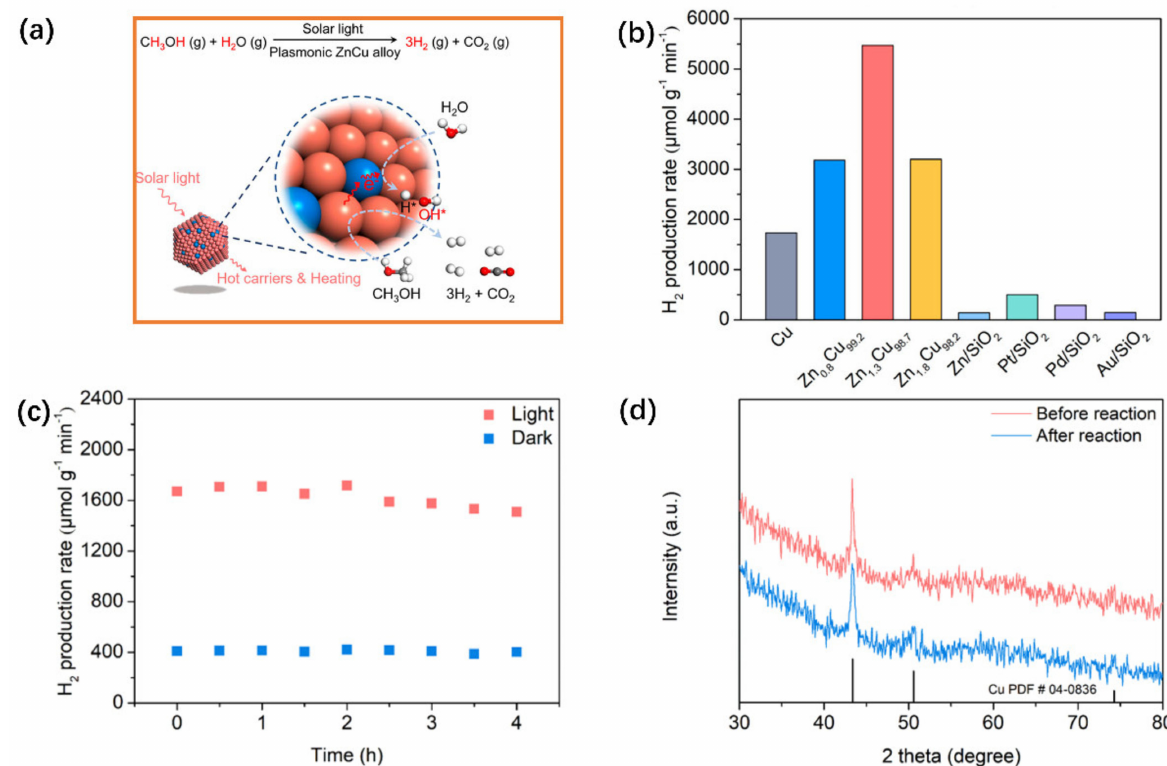
Figure 9. Solar-driven plasma ZnCu alloys for H 2 production: ( a ) Mechanism of plasma ZnCu alloy catalyzed methanol steam reforming reaction; ( b ) methanol steam reforming activity of different catalytic materials; ( c ) stability test of Zn 1 . 3 Cu 98 . 7 alloy; and ( d ) XRD of Zn 1 . 3 Cu 98 . 7 catalysts before and after reaction. Reproduced with permission [140]. Copyright American Chemical Society,